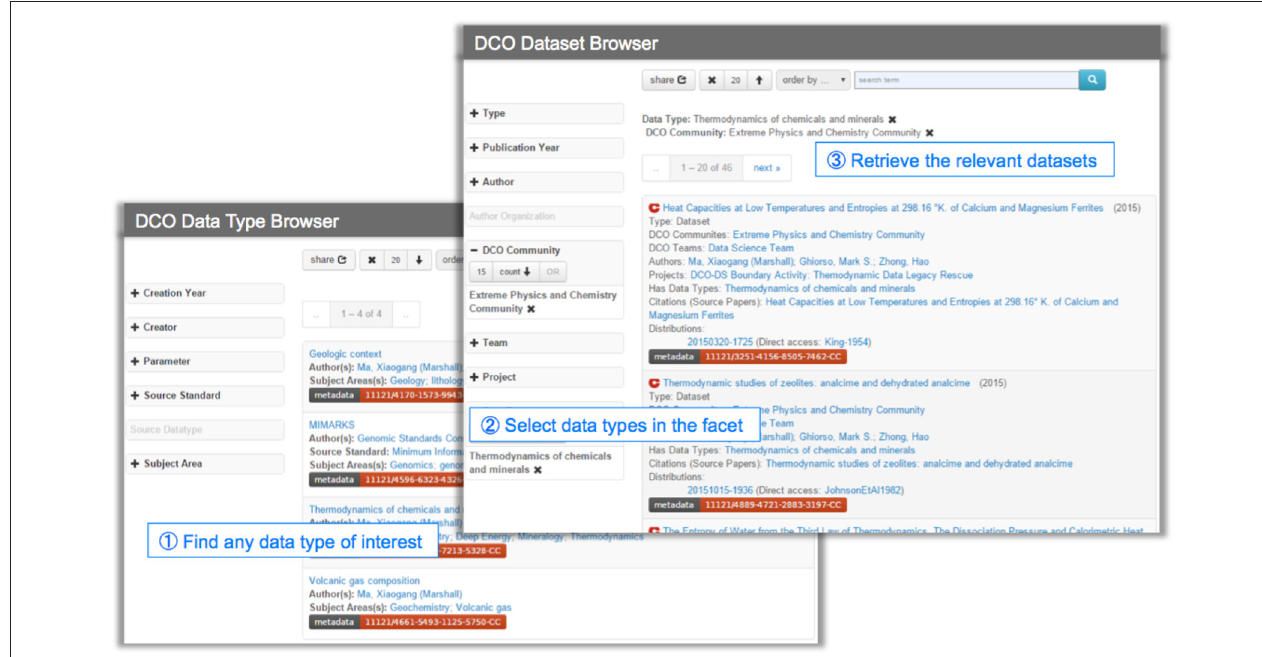
FIGURE 5 | Using DCO data type browser and DCO dataset browser to find datasets of